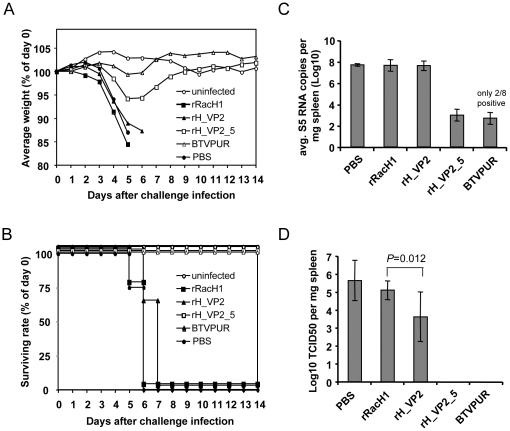
Protective efficacy of the recombinant vaccines against BTV-8 challenge in IFNAR−/− mice.(A) Average group weights after challenge. (B) Survival rate of IFNAR−/− mice after BTV-8 challenge infection. (C) BTV-8 RNA in spleen samples taken 14 days after challenge was quantified using real-time RT-PCR targeting segment 5. The average segment 5 RNA copies per mg of spleen are shown. (D) BTV-8 virus titers in spleen samples were determined by end-point titration of supernatants on Vero cells and shown as average TCID50 per mg of spleen. Differences in virus titres between the groups were statistically evaluated with a Kruskal-Wallis rank sum test.